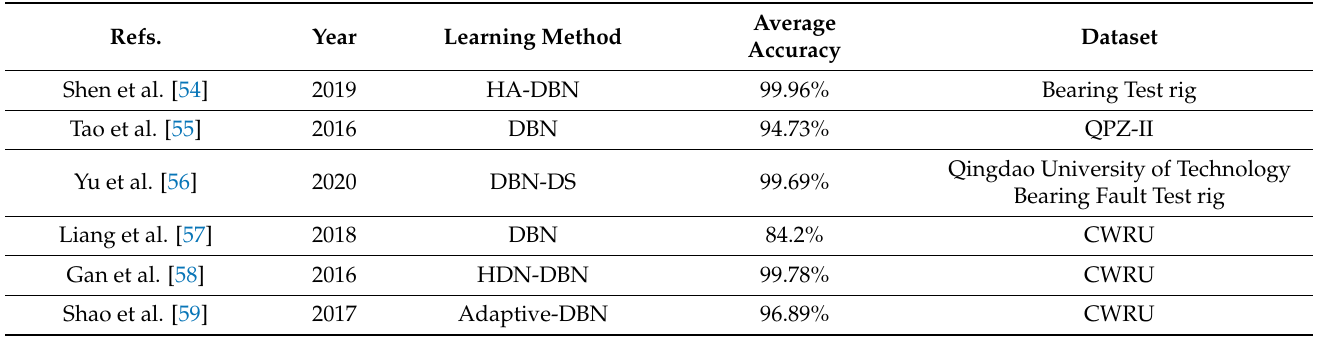
Table 6. DBN-based methods used for fault bearing diagnosis research comparison.